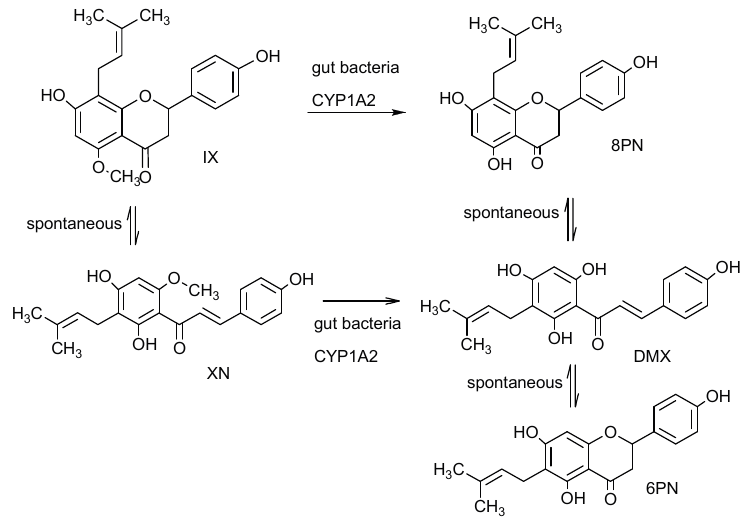
Scheme 1. Pathway for XN metabolism and production of its metabolites: IX, 6PN, 8PN, and DMX. Reproduced from reference